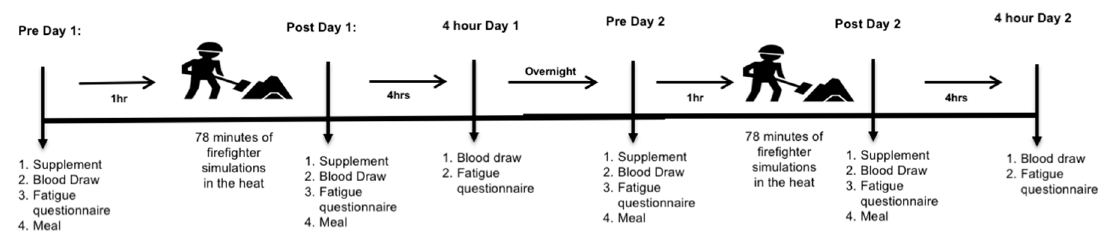
Figure 1. Exercise protocol. Subjects completed consecutive days of physical exercise in a heated environmental chamber. The supplement (either glutamine or placebo) was ingested before and after each exercise bout on both days.